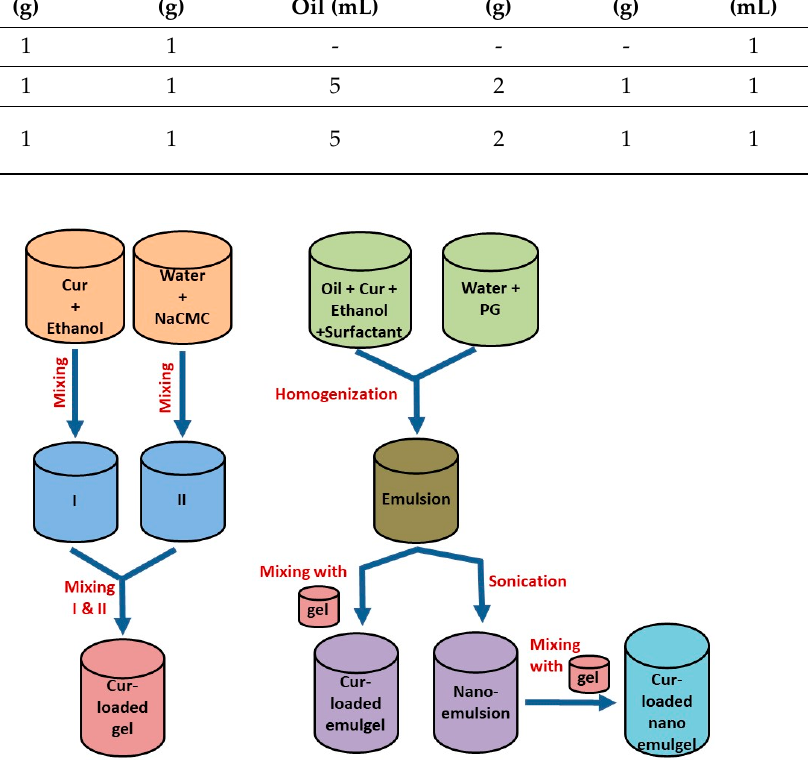
Figure 1. Schematic representation for the development technique of different Cur-loaded formu- lations .